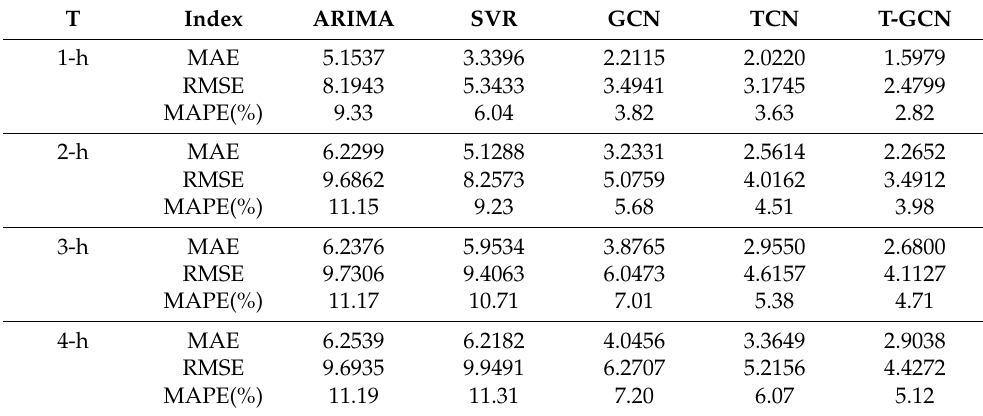
Table 1. Comparison of prediction performances of different